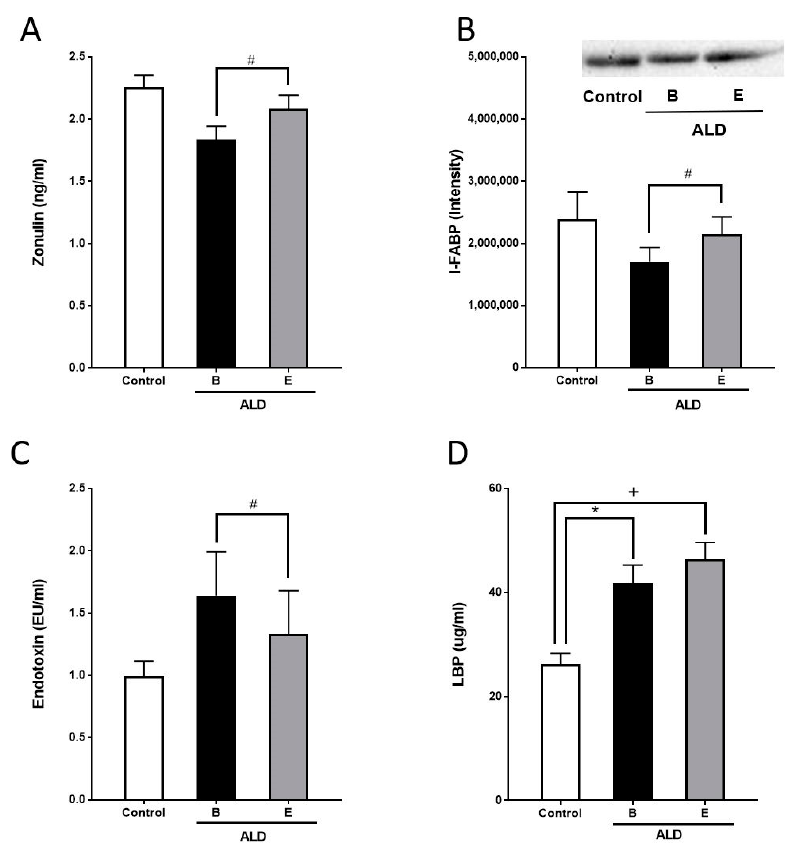
Figure 1. Serum markers of intestinal permeability in controls and patients with ALD before and after alcohol withdrawal. ( A ) Zonulin and ( B ) I-FABP protein concentrations, ( C ) endotoxin levels and ( D ) LBP protein concentration in serum of healthy controls and patients with ALD. ALD: alcohol-related liver disease, B: beginning of alcohol withdrawal, E: end of alcohol withdrawal, I-FABP: intestinal fatty acid binding protein, LBP: lipopolysaccharide binding protein. Data are shown as mean ± SEM. Levels of significance for: # p = 0.05, * p = 0.05, + p = 0.05. Nutrients 2021 , 13 , x FOR PEER REVIEW Activations of TLR2 and TLR4 transfected cells, respectively, being indicative of TLR2 and TLR4 ligand concentration in serum, were also significantly higher in ALD pa- tients than in controls (Figure 2). After the alcohol withdrawal activation of both, TLR2 and TLR4 transfected HEK293 cells, were significantly lower ( p < 0.05 for both); however, activation of both cell types was still higher than in controls ( p < 0.05).